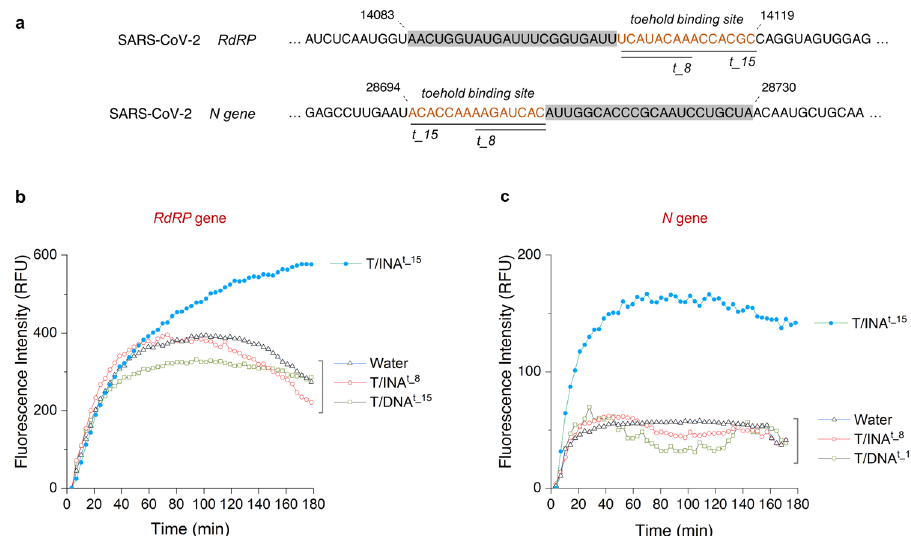
Fig. 4 The role of Initiator in the Template displacement. a Location of the toehold-binding sites for both RdRP and N genes. Typical curves illustrating the fl uorescence signal kinetics of the NISDA assay over time, designed for b , RdRP gene and c , N gene using different Initiators of T/DNA t-15 (solid blue circle), T/INA t-8 (hollow red circle), and T/INA t-15 (hollow green square). Water (hollow black triangle) means no Initiator, only M1 and M2. Source data for ( b , c ) are provided as a source data fi